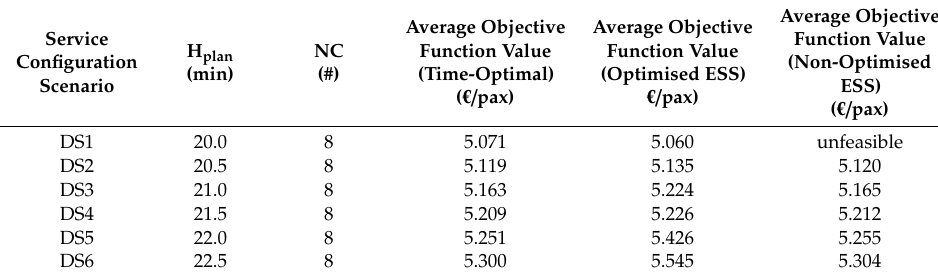
Table 8. Intervention scenario evaluation in disrupted conditions.